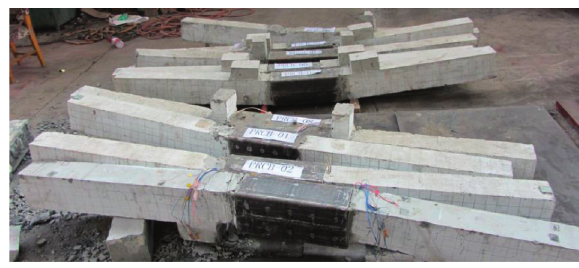
Figure 8: Specimen condition after